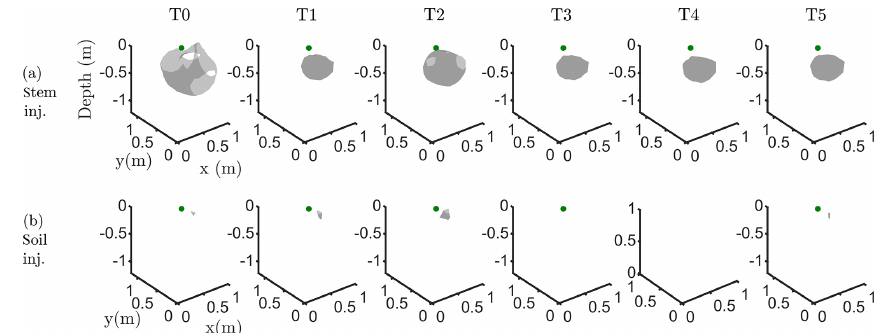
Figure C3. Iso-surface minimizing the F 1 function for plant A: during stem injection (a) and during soil injection (b) . Columns represent the six time steps from T 0 to T 5 . Green dot shows plant stem position. Threshold is defined by the misfit 25% of the normalized F 1 (value selected according to the evolution of the curve of sorted misfit F 1 , calculated for the tree injection at T 0 and kept constant for all the time